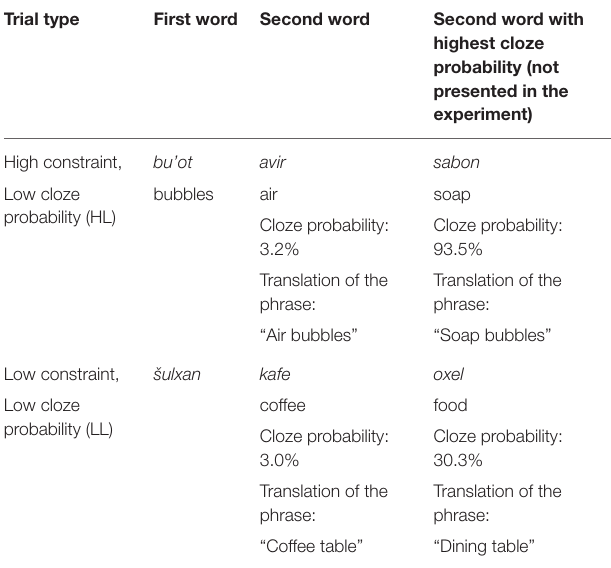
TABLE 1 | Example materials for Experiment